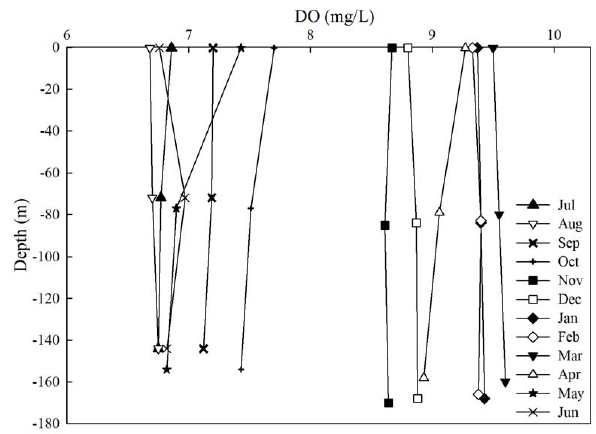
Fig. 5. Seasonal variation of DO concentrations at surface water Figure 5. Seasonal variation of DO concentrations at surface water (0.2 m), bottom layer 611 (0.2m), bottom layer (0.5m above the sediment) and the middle (0.5 m above the sediment) and the middle layer in front of the dam (ZG site), from July, 612 layer in front of the dam (ZG site) from July 2008 to June 2008 to Jun, 2009. 613